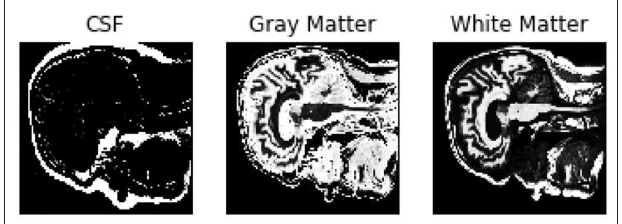
FIGURE 5 | Probabilities of the different brain tissues CSF, gray matter, and white matter.